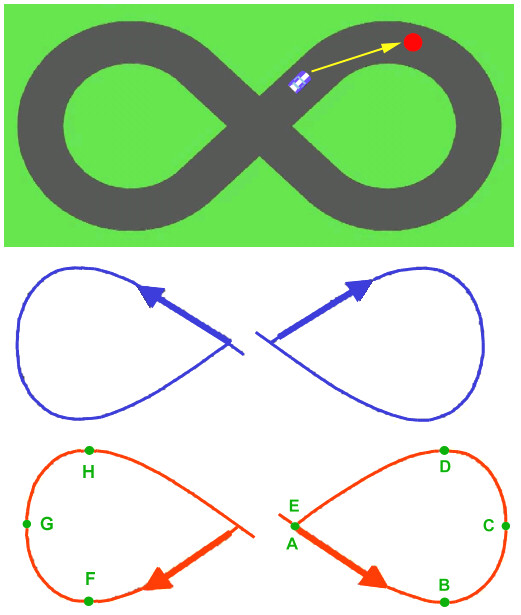
Tracking task. The top panel replicates the picture on the computer screen that includes the figure-of-eight path (black), the moving target (red circle), and the hand position (whitish car-shaped). The middle and bottom panels show the two tracking directions used in the experiments: clockwise-right/counterclockwise-left (blue), counterclockwise-right/clockwise-left (red). A - H are the eight control points used by the algorithm of performance evaluation.